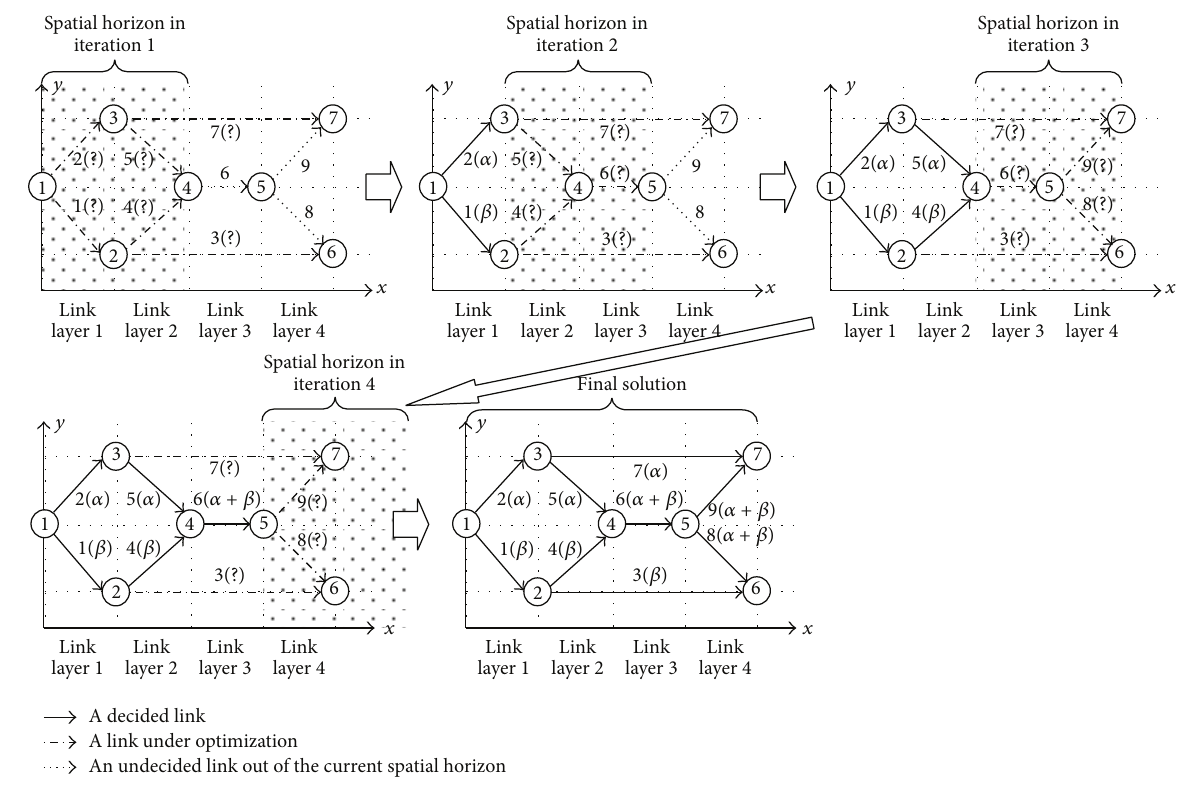
Figure 7: An illustration of spatial horizon receding